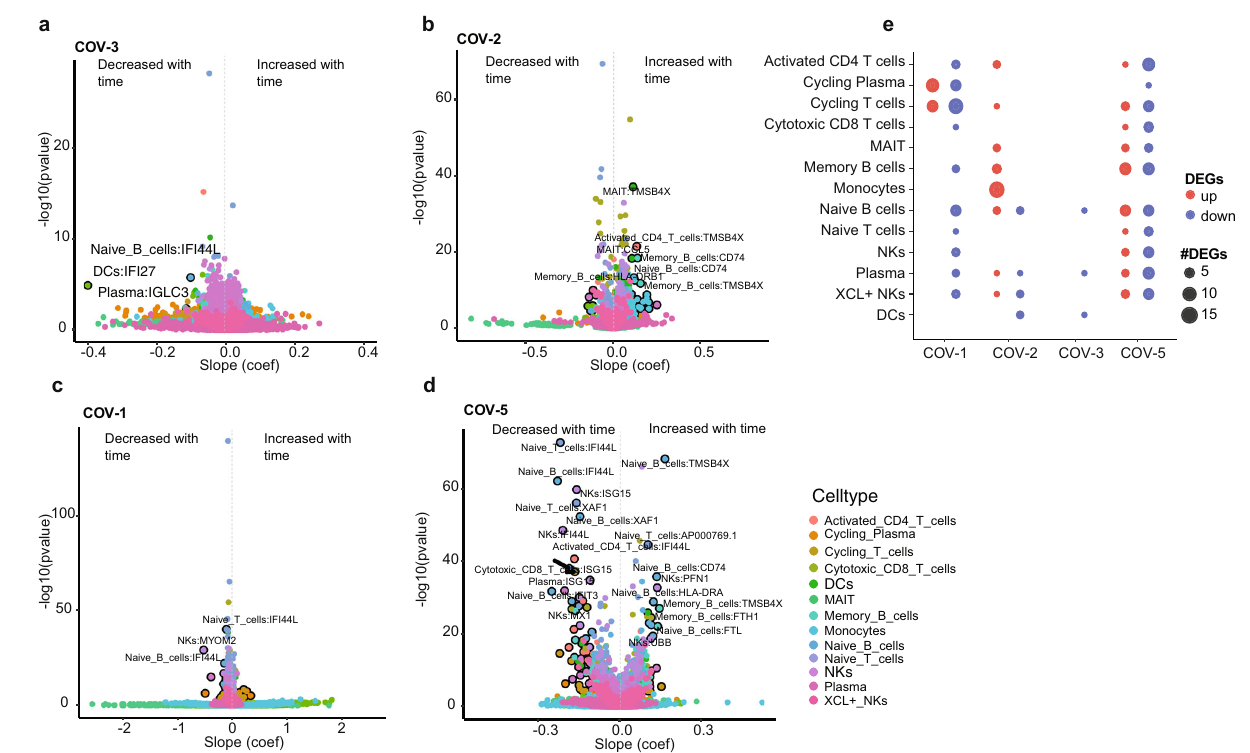
Fig. 7 | Heterogeneous immune responses by COVID19 patients during recov- ery. a Volcano plot showing temporal expression changes of individual genes in differentcelltypesduringtherecoveryofpatientCOV-3(female,41yearsold,mild symptoms, data on day D1/D4/D16), based on longitudinal scRNA-seq data in CNP0001102 3 . The x-axis shows the slope (coef fi cient) of gene expression change asalinearfunctionoftime.They-axisshowsthecorrespondingadjustedpvalueof the slope. b – d Same as ( a ) but for patients ( b ) COV-2 (male, 45 years old, mild symptoms, data on D1/D4/D7/D10/D16), ( c ) COV-1 (male, 15 years old, mild symp- toms, data on D1/D4/D16), and ( d ) COV − 5 (female, 85 years old, severe symptoms,